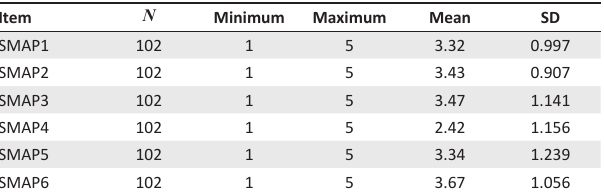
TABLE 10: Descriptive statistical analysis (Section B – self-motivation and productivity).